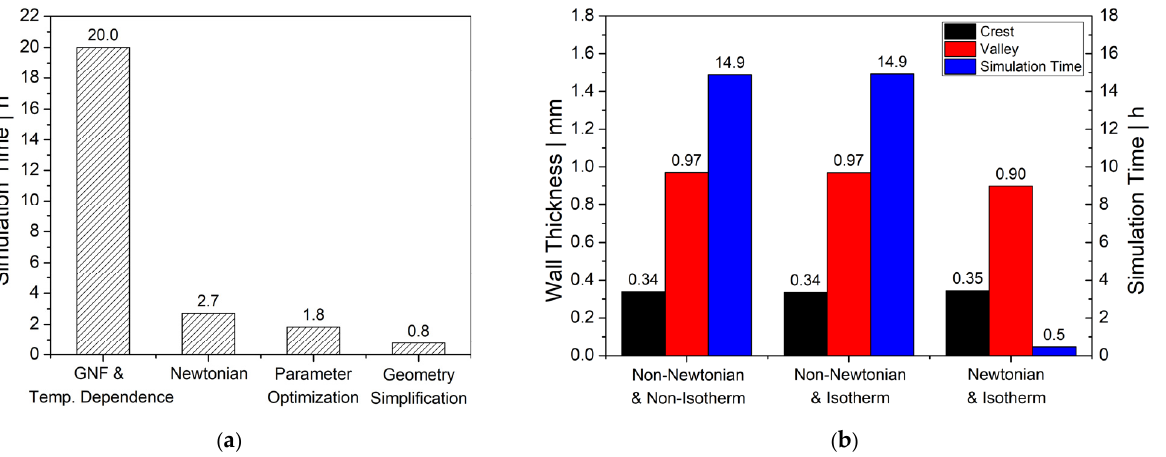
Figure 4. ( a ) Optimization of the simulation time, ( b ) comparison study of wall thickness distribution and simulation time.